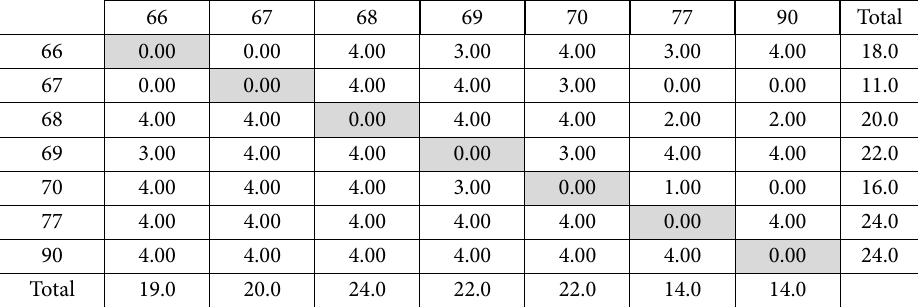
Table 5. Direct influence matrix for C3 Processes